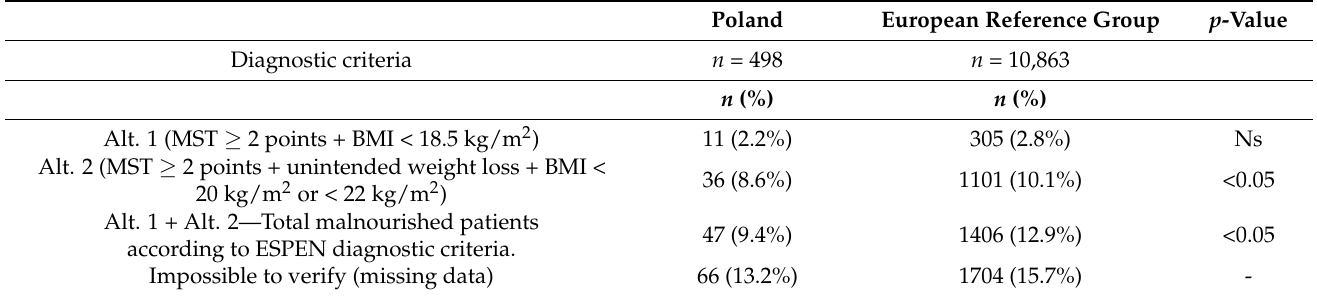
Table 5. Prevalence of malnutrition according to ESPEN diagnostic criteria established in